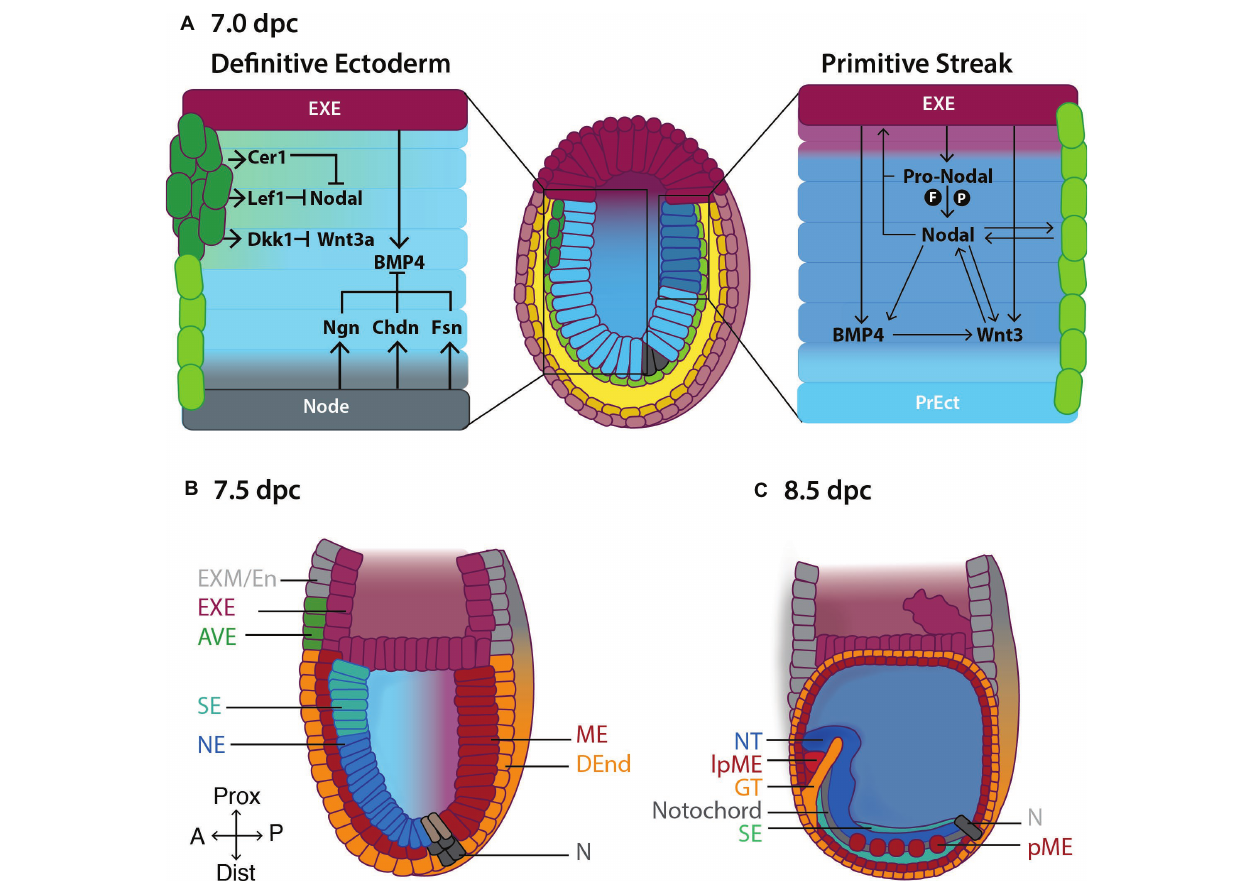
FIGURE 2 | Formation of the primitive body plan following gastrulation in the mouse. (A) Right hand panel: Pro-Nodal secreted from the extraembryonic ectoderm (EXE) is converted to Nodal in the presence of the convertases Furin (F) and Pace4 (P). Nodal acts on the visceral endoderm (light green cells) to regulate the expression of pro-Nodal and production of Nodal. A feedback system is established between Nodal, BMP and Wnt3 causing primitive ectoderm (PrEct) cells on the posterior side to ingress through the primitive streak, which continues to elongate in a proximal-distal direction from 6.5 dpc. Cells that migrate through the primitive streak form the definitive mesoderm (ME) and endoderm (DEnd) germ layers. Left hand panel: On the anterior side of the embryo, the anterior visceral endoderm (AVE; dark green cells) secretes the Nodal antagonists Cer1 and Lef1, and the Wnt3 antagonist Dkk1, inhibiting Nodal and Wnt3 signaling and thus establishing the definitive ectoderm germ layer by 7.0 dpc. BMP4 is secreted from the EXE, while BMP4 antagonists including Noggin (Ngn), Chordin (Chd) and Follistatin (Fsn) are secreted from the Node (N), establishing a gradient of BMP4 across the definitive ectoderm, such that by (B) 7.5 dpc, BMP4-mediated SMAD signaling in the proximal definitive ectoderm produces surface ectoderm (SE) while the distal definitive ectoderm differentiates to neurectoderm (NE) in the absence of SMAD signaling. (C) Following the completion of gastrulation at ~7.5 dpc, the ME differentiates to give rise to the paraxial mesoderm (pME) and lateral plate mesoderm (lpME), the DEnd produces the gut tube (GT) and the NE gives rise to the neural tube (NT). Additional key: EXM/En, extraembryonic mesoderm/endoderm; Prox, proximal; Dist, distal; A, anterior; P,